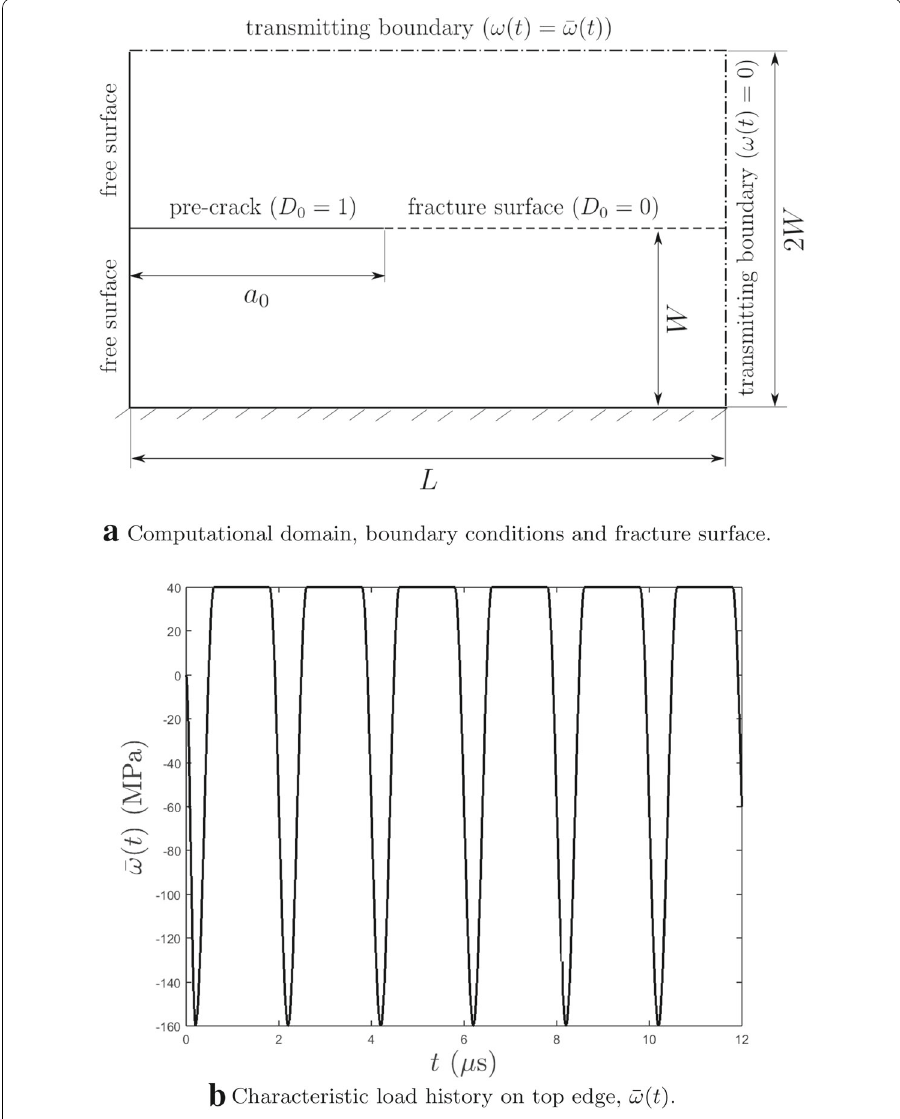
Fig. 3 Problem description for planar fracture example with crack closure and cyclic far-field loading